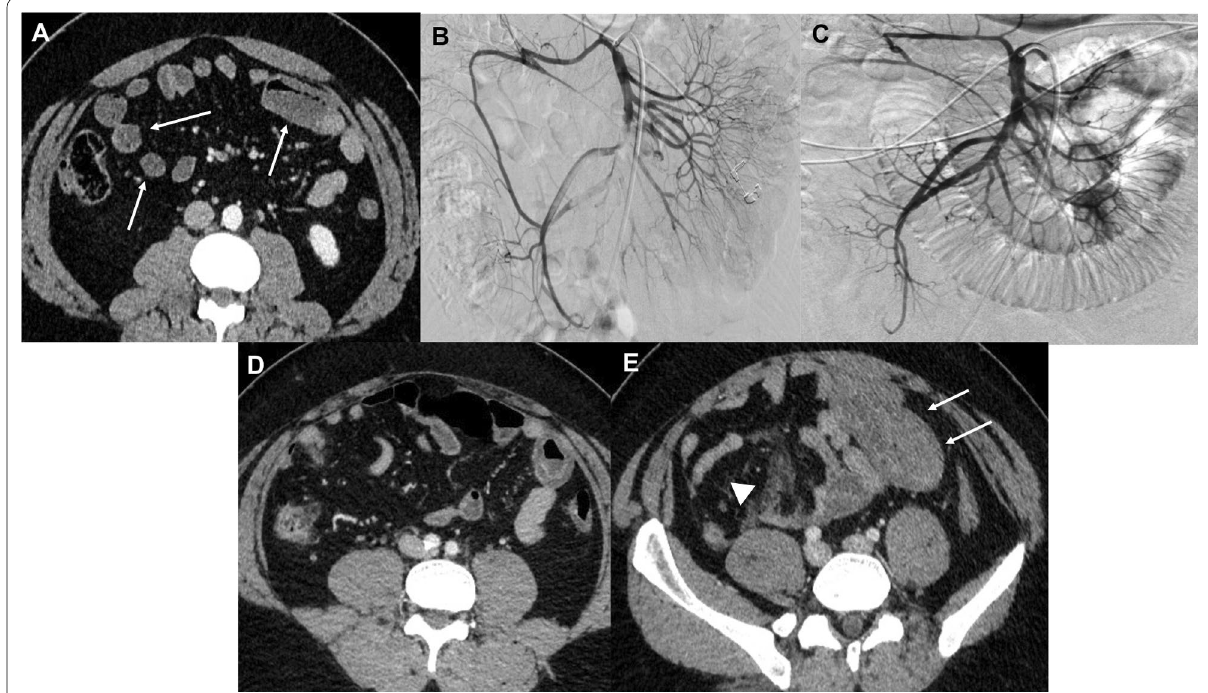
Fig. 2 A 25-year-old male patient presented with early acute mesenteric ischemia (embolus of the superior mesenteric artery, SMA). Decrease in enhancement of the small bowel (arrow) compared to non-ischemic ones (arrowheads) on baseline CT portal-venous phase ( a ) with complete occlusion of the distal branches of the SMA ( b ). Complete recanalization of the SMA by thrombus-aspiration and in situ thrombolysis ( c ). Contrast-enhanced CT (portal venous phase) performed 12 h after revascularization for systematic post-procedural evaluation showed a thickened jejunal loop (arrow) with hyperenhancement of the mucosa and edema of the submucosa consistent with reperfusion injury ( d ). 24 h after revascularization, the patient has bloody diarrhea with anemia. On portal-venous phase CT, the previously thickened small bowel segment showed marked thickening with intra-luminal hyperattenuating material consistent with hemorrhage (arrow) and mesenteric fat stranding (arrowhead) ( e ). The patient was closely monitored surveillance, and no laparotomy was